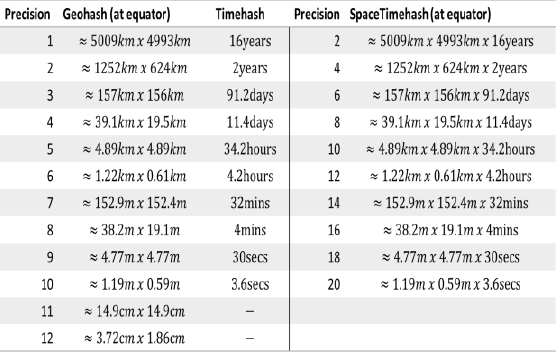
Table 1. Precision achieved using Geo-temporal hashes (Space Time Boxes)